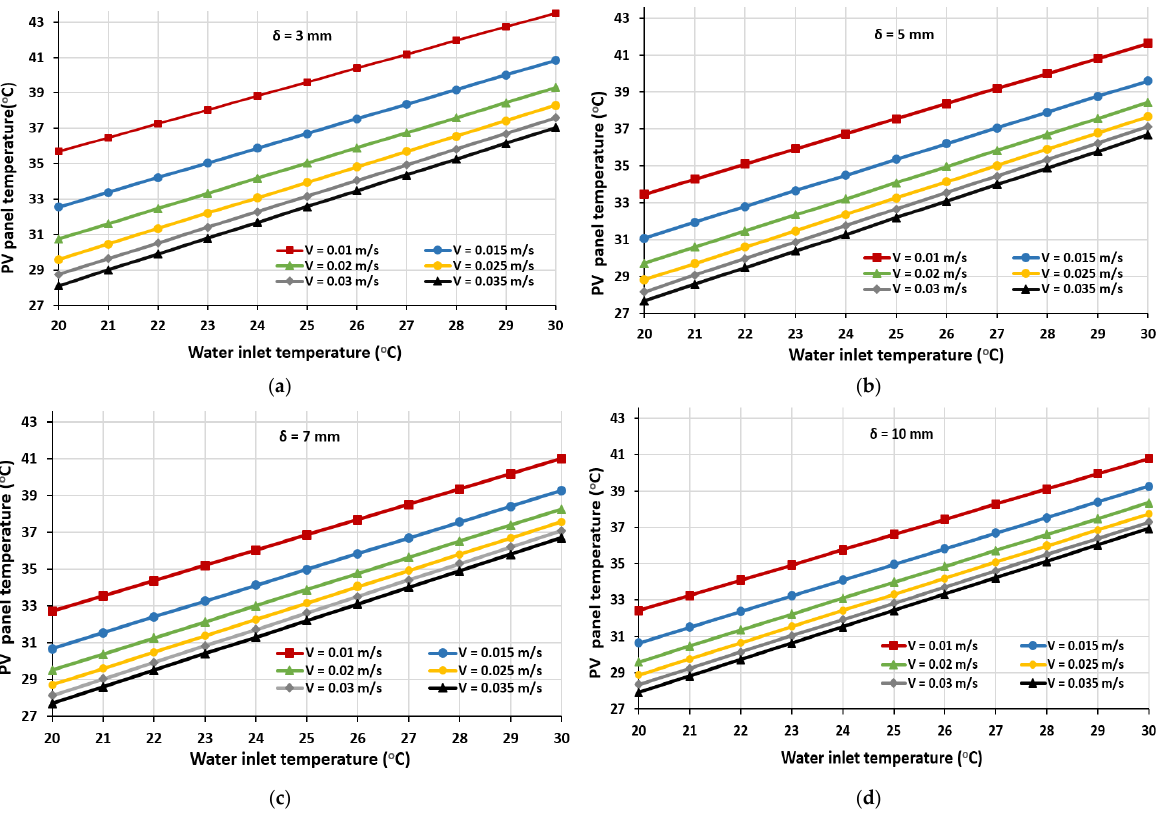
Figure 4. Effect of water velocity on the cooling of the PV cells for different thicknesses: ( a ) δ = 3 mm, ( b ) δ = 5 mm, ( c ) δ = 7 mm, ( d ) δ = 10 mm.